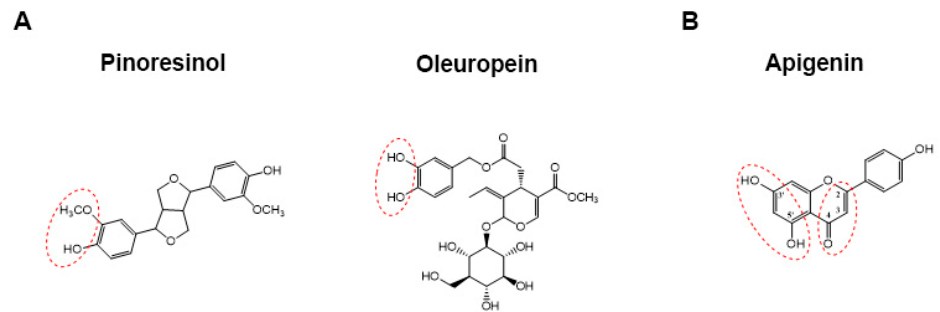
Figure 1. Structural features related to the antioxidant capacity of polar phenols. ( A ) o -dihydroxy (catechol) moiety; ( B ) 2,3-double bond in conjunction with a 4-keto function and the additional presence of 3 ′ - and 5 ′ -hydroxyl groups.